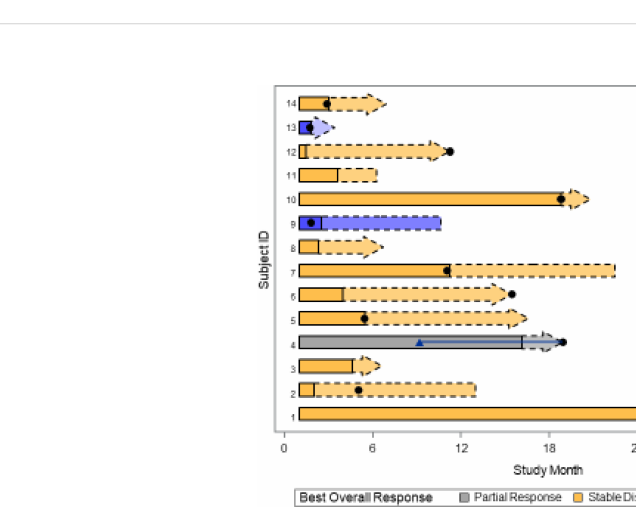
FIGURE 2 Swimmer plot of the 14 evaluable patients treated with